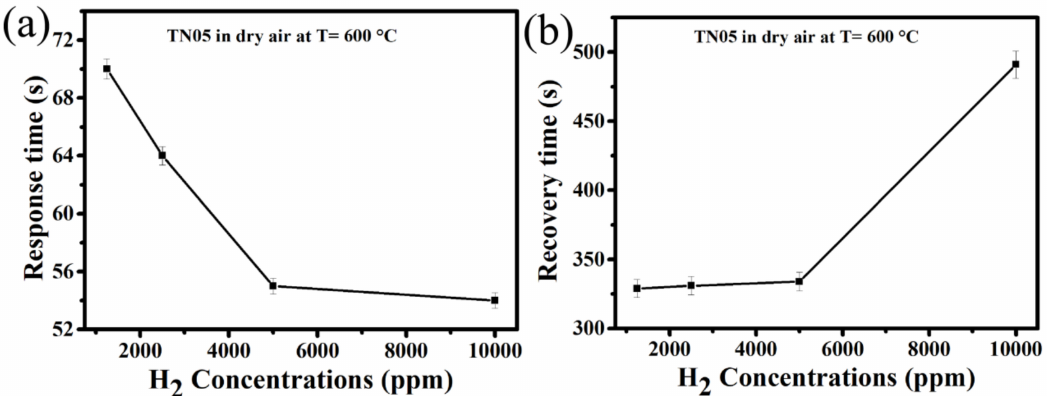
Figure 9. Relationship between H 2 concentrations and ( a ) the response time ( b ) the recovery time for 0.5% Ni-doped TiO 2 at 600 ◦